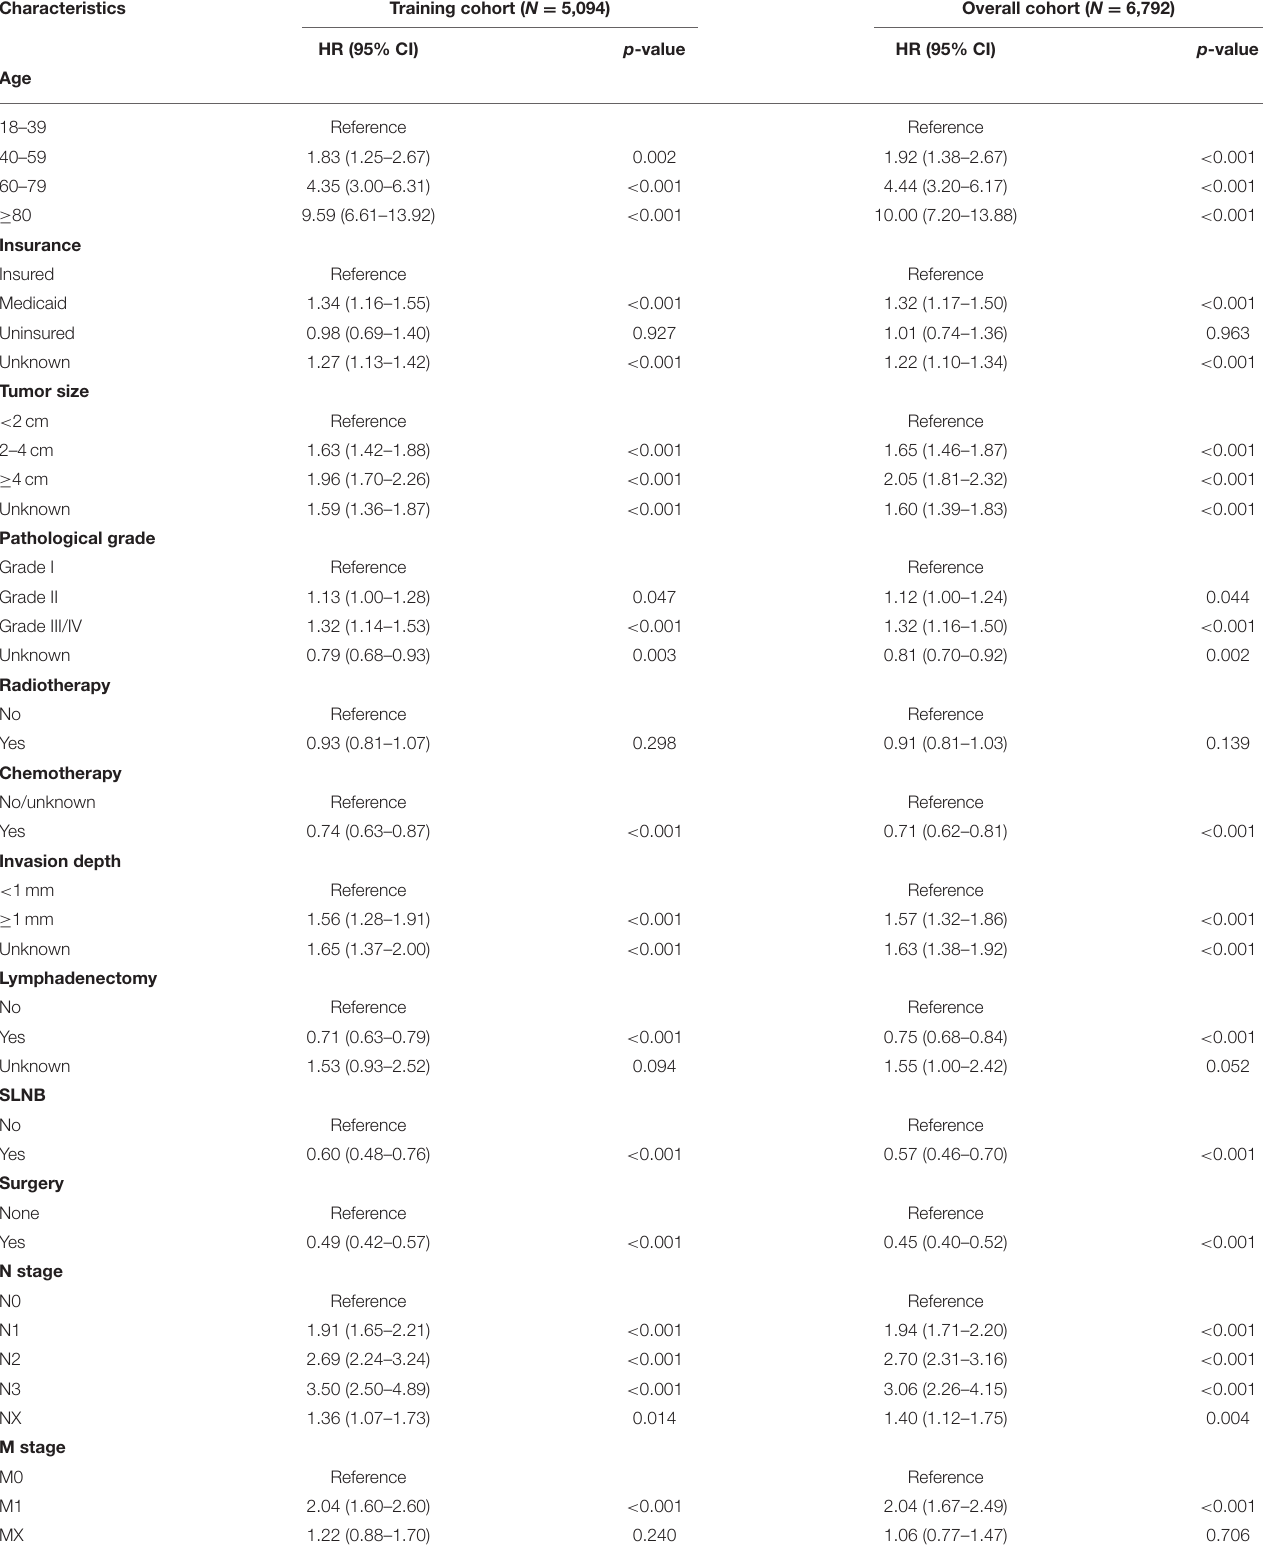
TABLE 2 | The results of multivariate cox proportional hazard risk model for overall survival (OS).